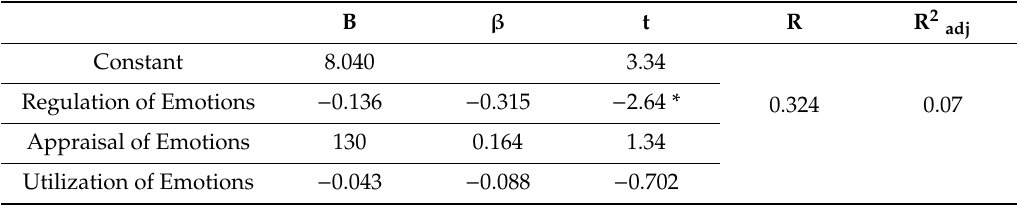
Table 4. The ability of the trait emotional intelligence to predict LF / HF power during